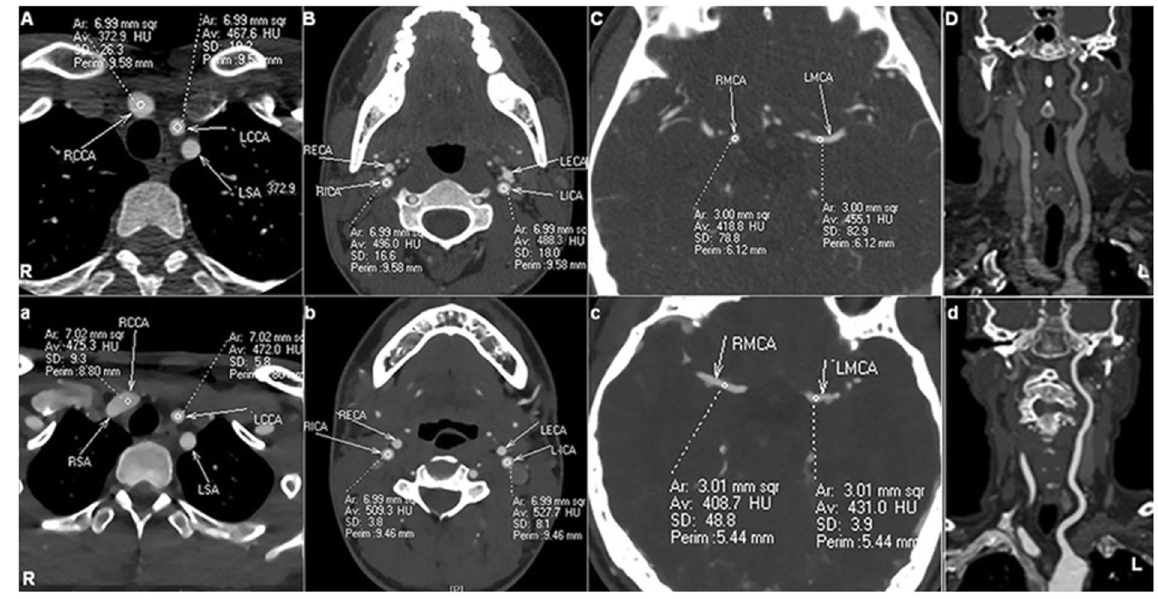
Figure 2. Measurements of the objective image quality in the head and neck of two 12-year-old boys reconstructed with the FBP algorithm and the IMR algorithm. The ROIs for the CT values and noises were measured for both FBP/IMR groups in the origin of the bilateral CCA ( A/a ) and ICA ( B/b ) and the bilateral M1 segments of the MCA ( C/c ). The CPR is shown in column ( D/d ). The CT values of the ROIs of the IMR group were significantly higher (566.8, 546.2 and 531.1 HU) than those of the FBP group (319.8, 356.9 and 295.1 HU) ( p < 0.001), whereas the image noises were significantly lower in the IMR groups than those in the group FBP ( p < 0.001). Abbreviations: FBP, filtered back projection; IMR, iterative model construction; ROI, region of interest; CCA, common carotid artery; ICA, internal carotid artery; MCA, middle cerebral artery; CPR, curved planar reconstruction. R, right; L,